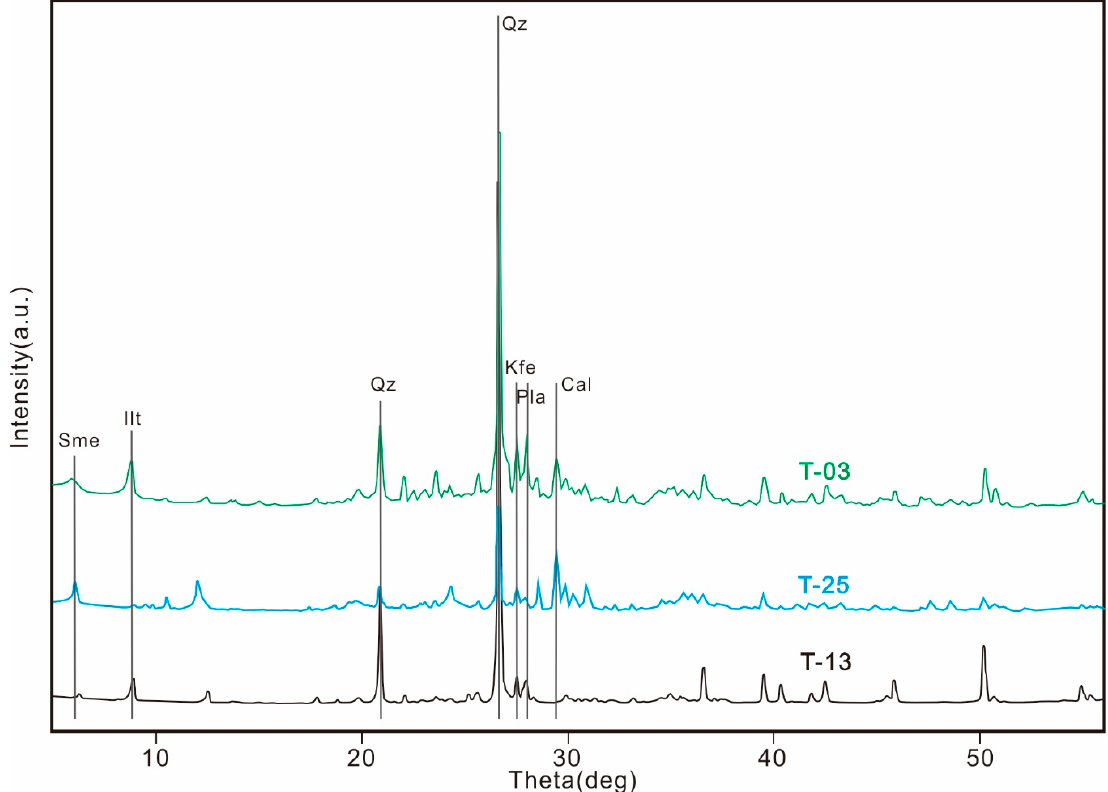
Figure 2. XRD spectra of three selected samples. Sme: smectite, Ilt: illite, Qz: quartz, Kfe: K-feldspar, Pla: plagioclase, and Cal: calcite.